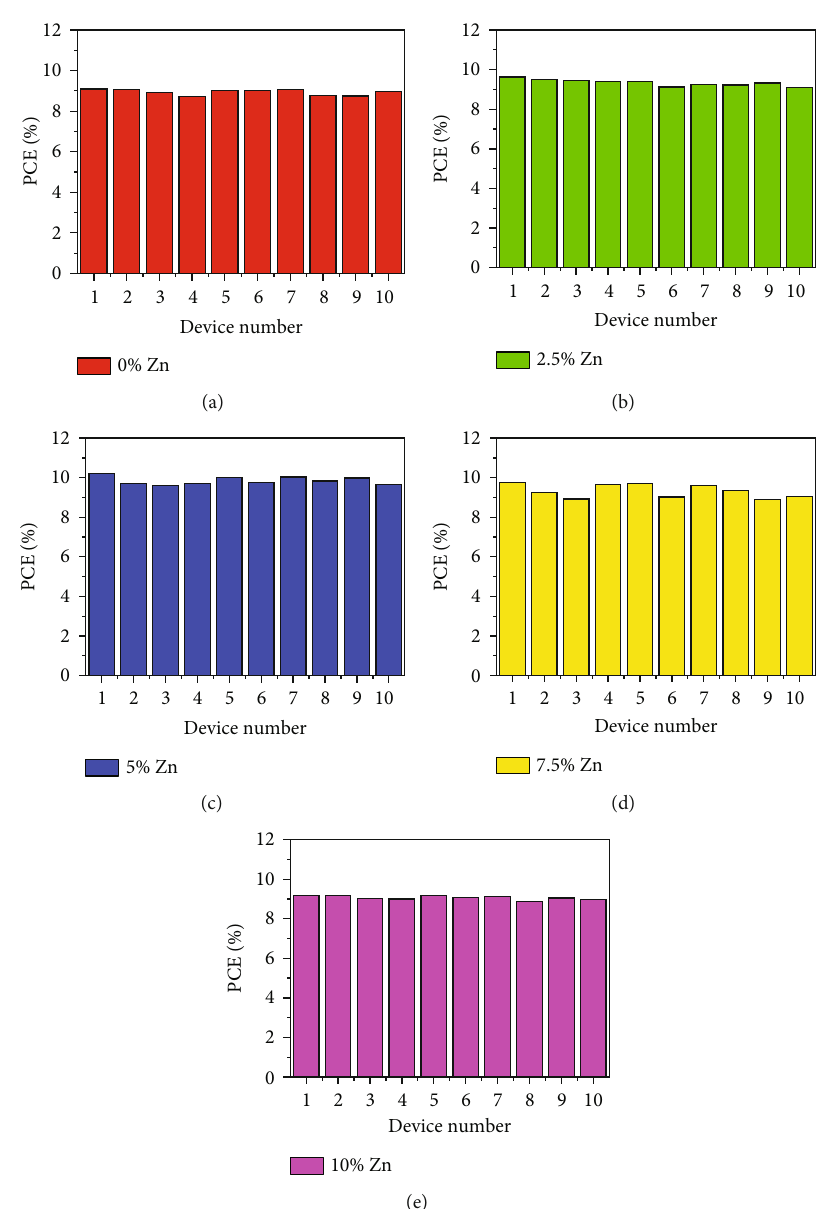
Figure 8: PCE distribution of PSCs based on Zn-SnO